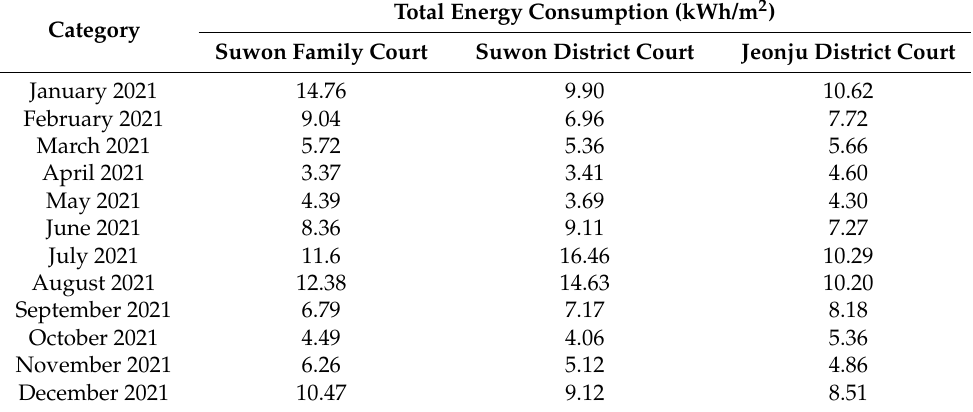
Table 7. Total energy consumption of Korean courthouse buildings (G-SEED certified and after insulation thickness standard revision).